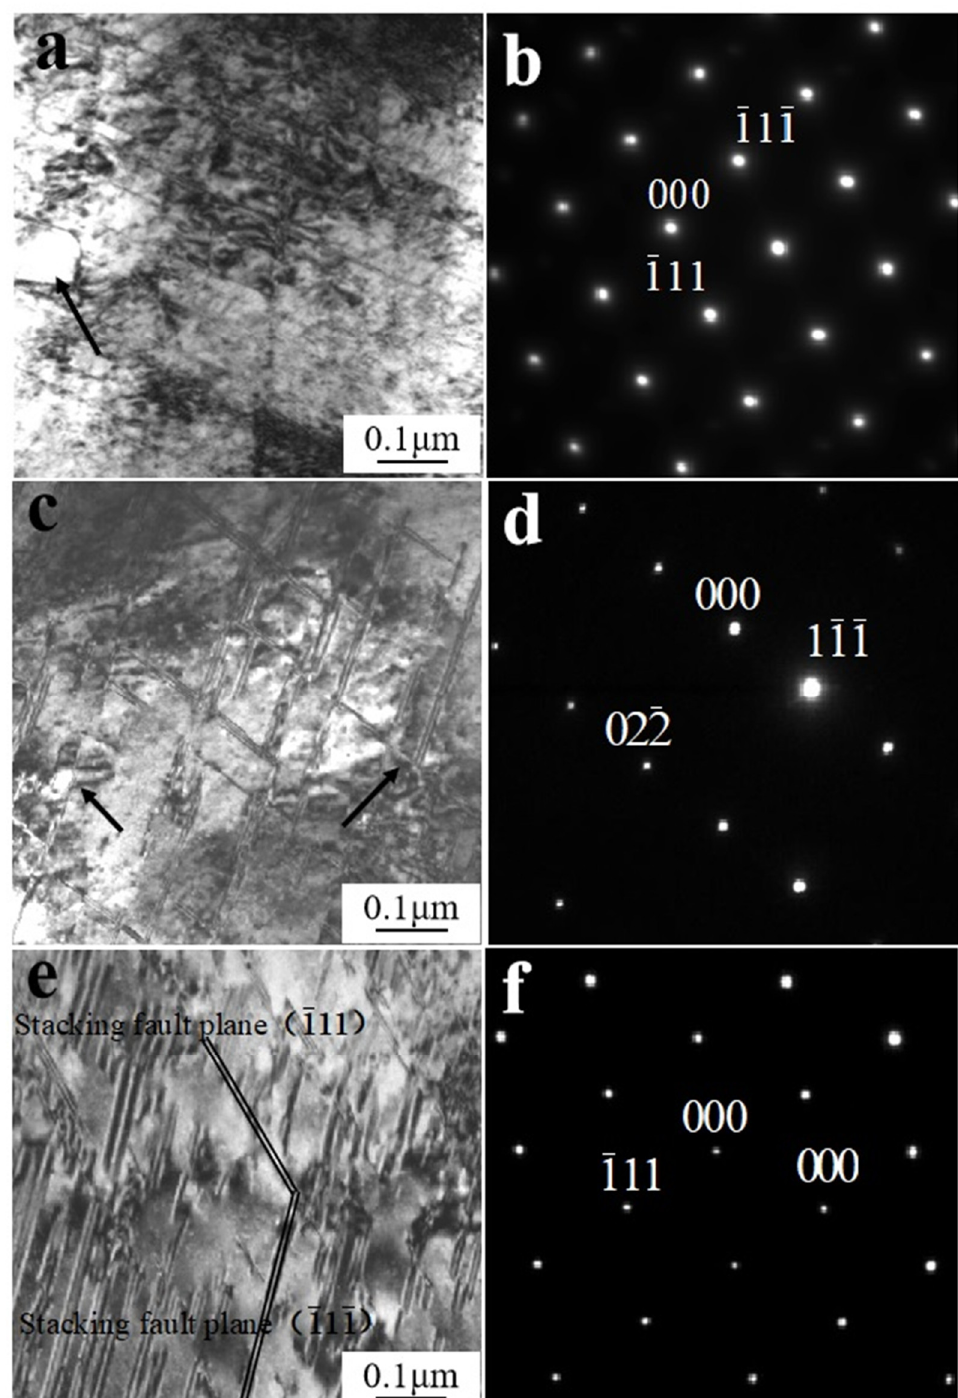
Figure 3. Stacking faults in the matrix of W f /Cu 82 Al 10 Fe 4 Ni 4 composites after dynamic compression at high temperatures: ( a ) 200 °C, 1600 s −1 ; ( b ) SADP of ( a ); ( c ) 400 °C, 1600 s −1 ; ( d ) SADP of ( c ); ( e ) 600 °C, 1600 s −1 ; ( f ) SADP of ( e ).